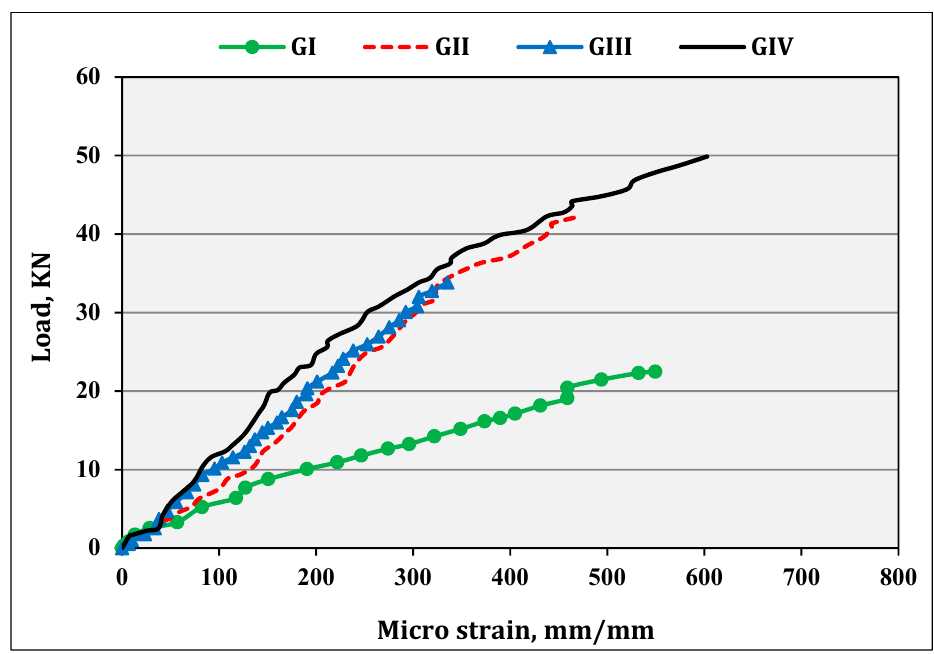
Figure 12. Load vs. tensile strain in externally bonded carbon fiber reinforced polymer EBR-CFRP laminates at mid-span for an average of tested groups.